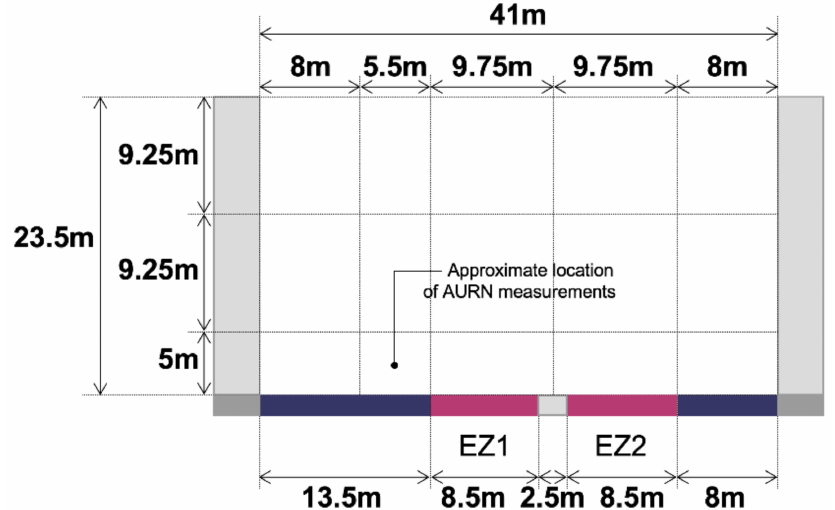
Figure 6. Street section dimensions and model grid adopted in our modelling of 2012 annual mean NO 2 concentrations beside Marylebone Road; also illustrated are emission zones, EZ1 and EZ2, and the approximate location of AURN